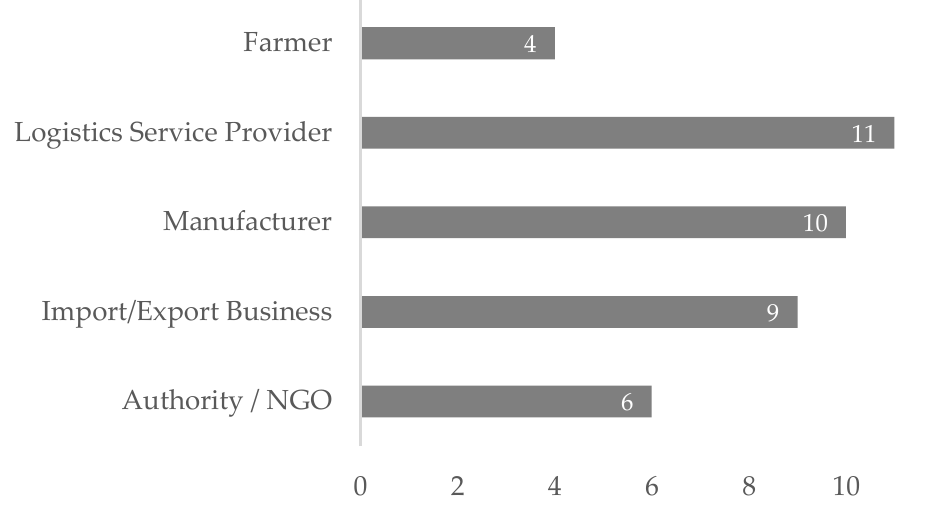
Figure 4. Value chain actors.